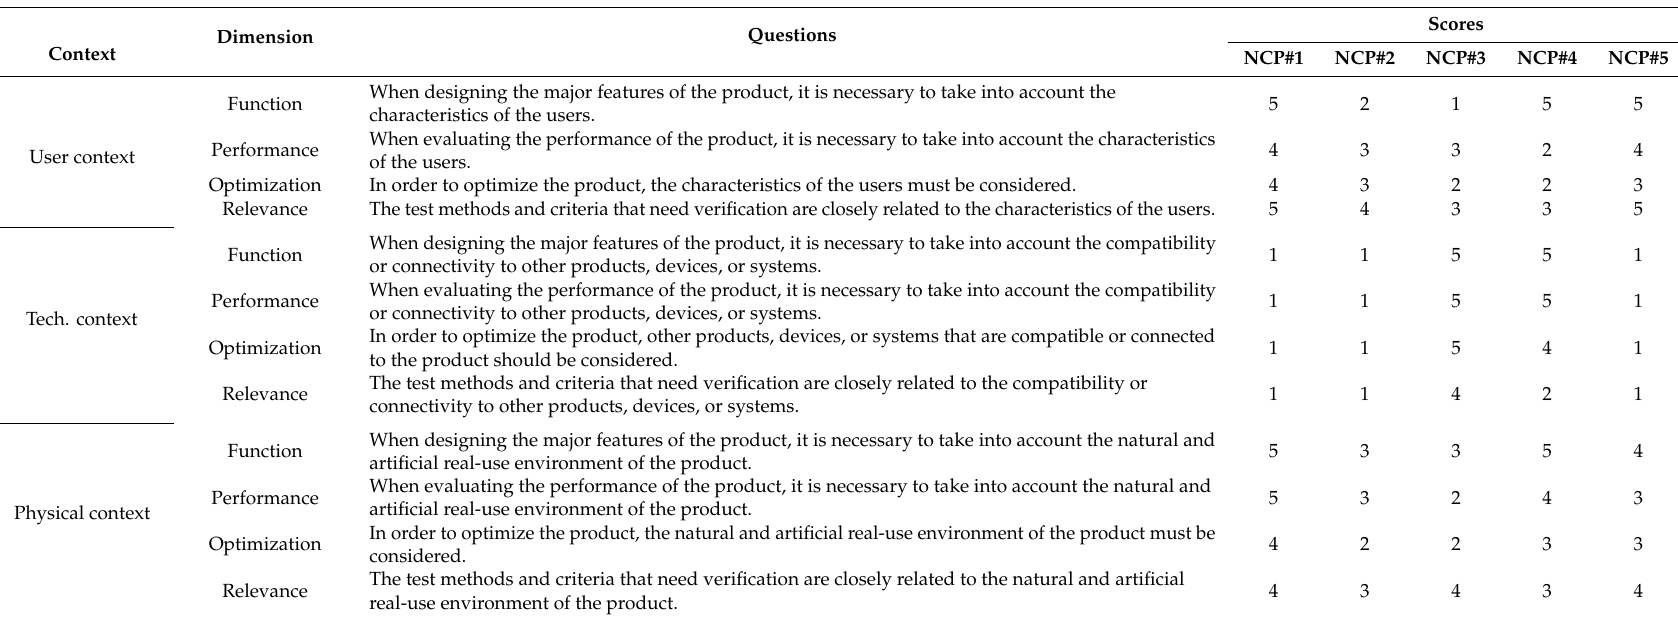
Table 3. Sample Analyses of